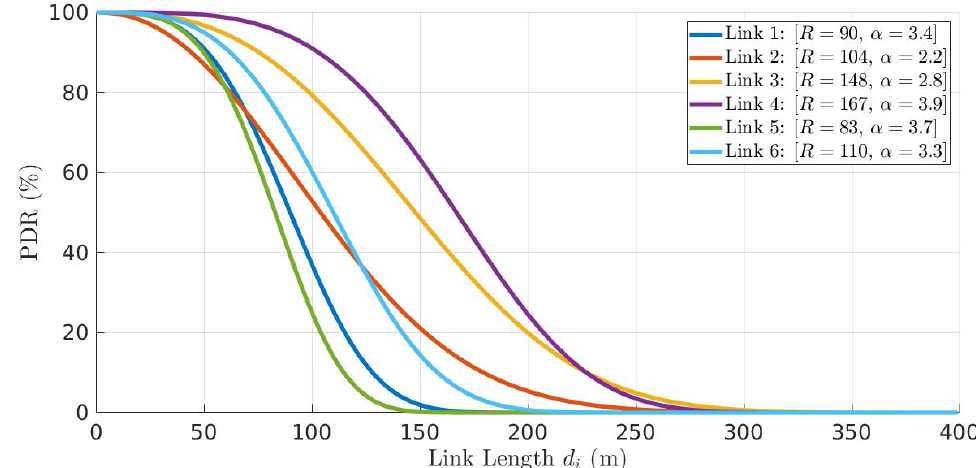
Figure 6. PDR models of six links as a function of link length d i , where link i connects nodes i and i + 1, ∀ i ∈ [ 1,6 ]